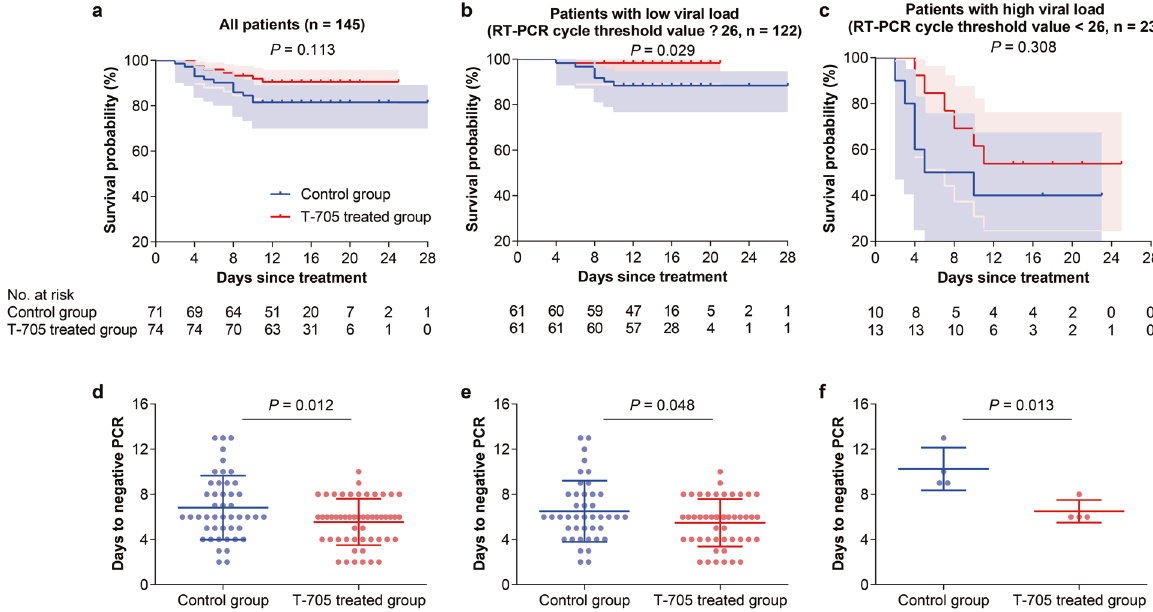
Fig. 5 Effect of T-705 treatment on survival time and viral clearance. a – c Kaplan-Meier curves for T-705 treatment effect on the probability of survival. Kaplan – Meier survival curves with 95% con fi dence bands are shown by treatment arm for all 145 patients ( a ), for 122 patients ( b ) with low-baseline viral loads (RT-PCR cycle-threshold value ≥ 26), and for 23 patients ( c ) with high-baseline viral loads (RT-PCR cycle-threshold value <26). d – f The days to viral clearance of SFTSV RNA. The mean (standard deviation) days to viral clearance are shown for all patients ( d ), for patients ( e ) with low-baseline viral loads, and for patients ( f ) with high-baseline viral